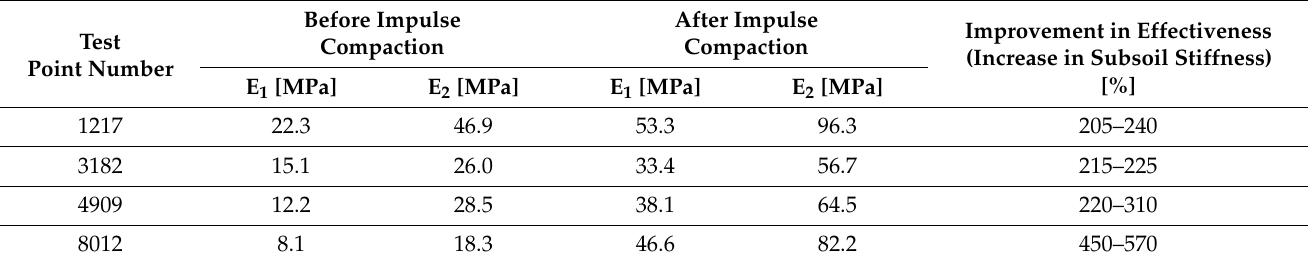
Table 4. Test results of the effectiveness of impulse